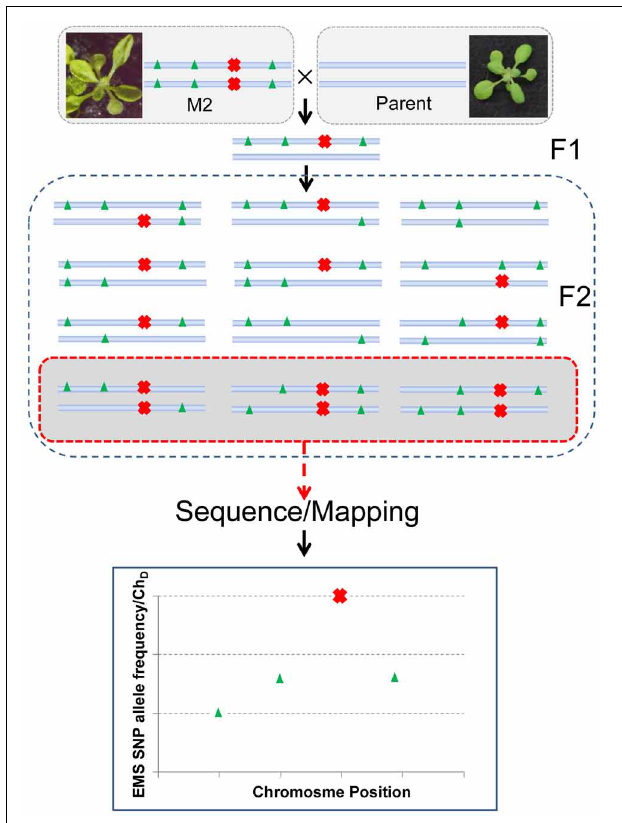
FIGURE 2 | The backcross to parent principle for identifying the causative EMS generated SNP. The M2 mutant is crossed with the parent and allowed to self-pollinate. If the mutation (red cross) is recessive the F2 progeny will segregate for the mutation in a 1:3 ratio. Individuals showing the mutation are pooled and a bulk DNA prep is sequenced. Because the mutation has been selected for the causal SNP should be homozygous in all reads. This can be represented as the allele frequency or the dischordant chastity statistic (Ch D ) if using NGM software. Linked EMS mutations (green triangles) will have a SNP allelic frequency approaching 1 the closer they are to the causative mutation. Resolving closely linked mutations will be dependent on their distance to the causal mutation, the sequencing coverage, and the number of F2s used. The simplified scheme shown assumes no differences between the parent and reference genome. Sequencing the parent genome is required if differences are expected between the reference genome and the parental strain